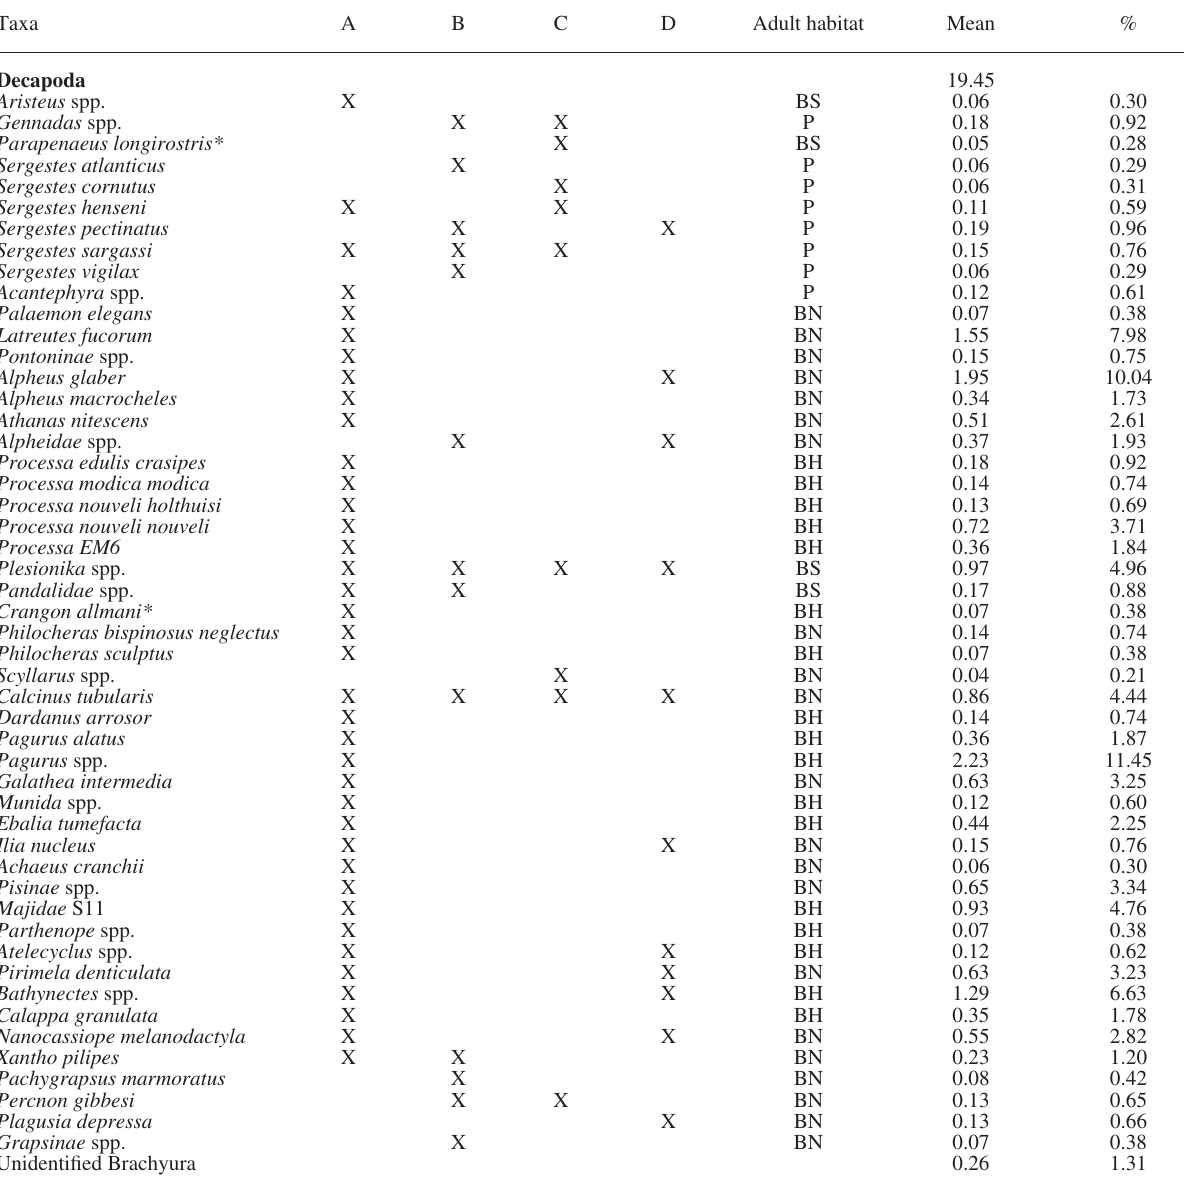
Table 1. – List of decapod larvae caught. Horizontal distribution displayed: a (nearshore stations around gran canaria and in the warm lee region), B (eddy region) c (upwelling filament region) and d (undisturbed zone). adult habitat (BH, benthic species with wide depth range distribution; Bn, benthic nearshore species; Bs, to benthic shelf/slope species; P to larvae of pelagic species). Mean values of abundance (larvae/100 m 3 ) and their percentage of total. (*) First records for the canary islands. taxa